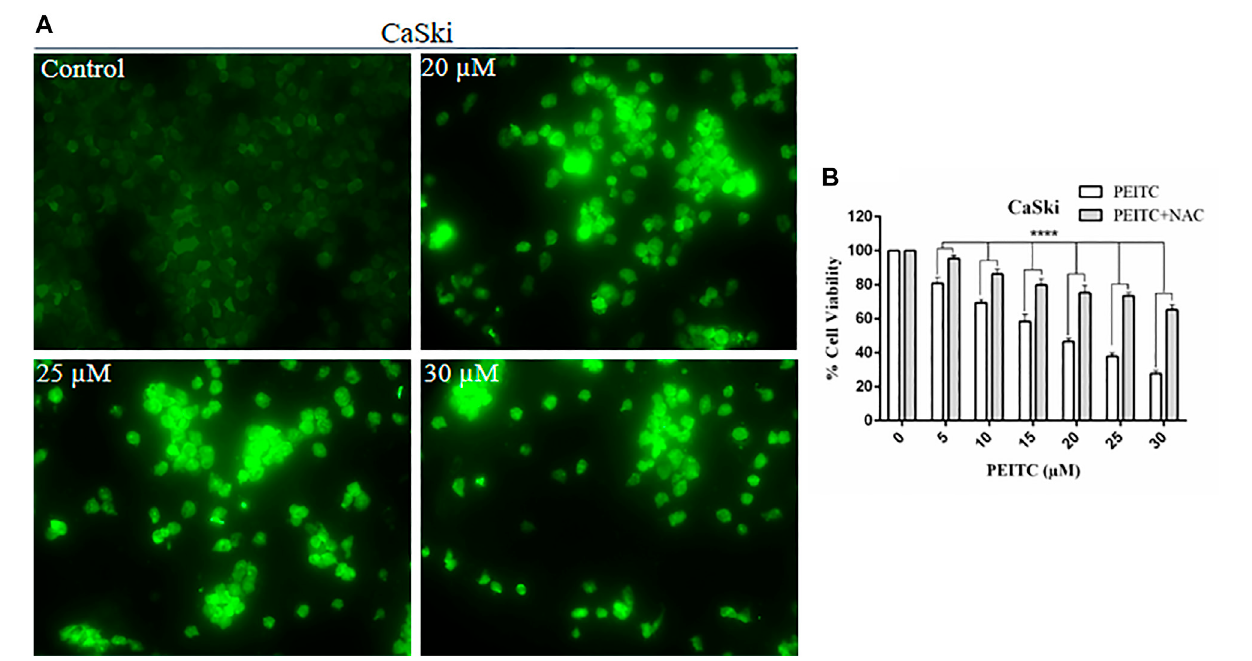
FIGURE 7 | Analysis of ROS generation using DC-FDA staining on CaSki cells treated with PEITC for 24 h and the images were captured by fl uorescence microscopy. (A) PEITCtreatmentresultedinsigni fi cantproductionofROSincervicalcancercells. (B) PercentcellviabilityofPEITCtreated(20,25and30 μ M)CaSkicells was assessed in the presence of ROS inhibitor, NAC, by MTT assay. The data represents mean ± SD of three independent experiments. * p value < 0.05 compared with the untreated control was considered statistically signi fi cant.